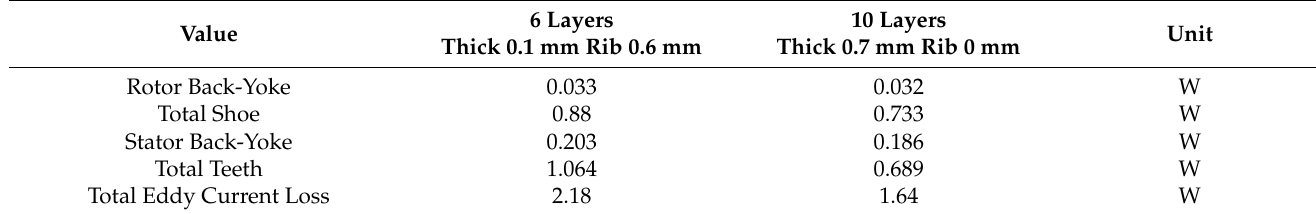
Table 2. Preliminary simulated